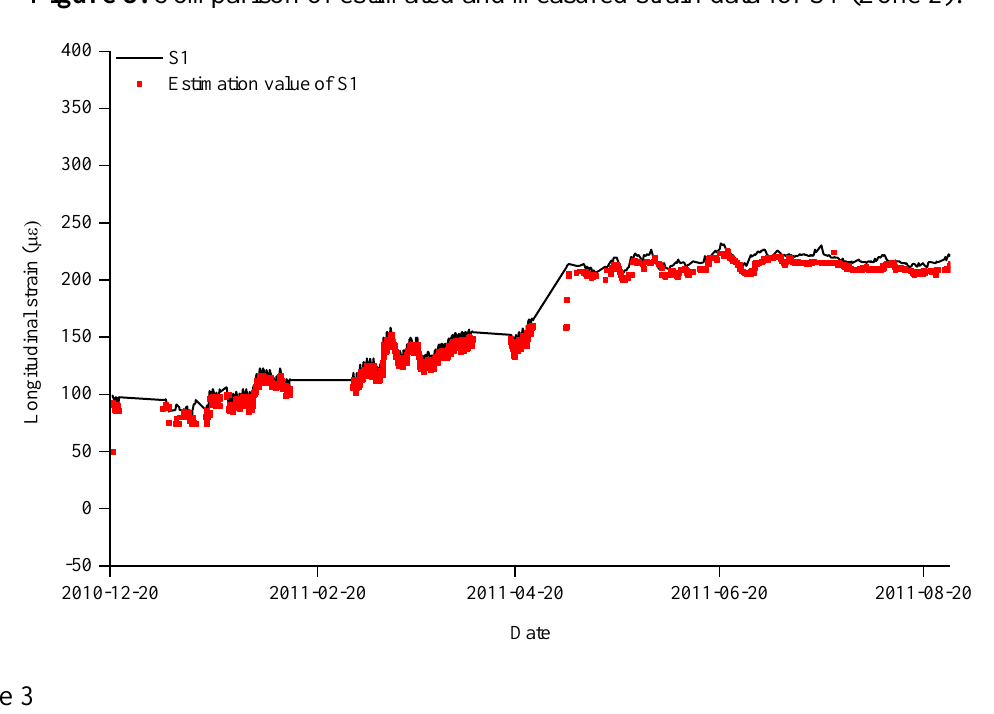
Figure 8. Comparison of estimated and measured strain data for S1 (Zone